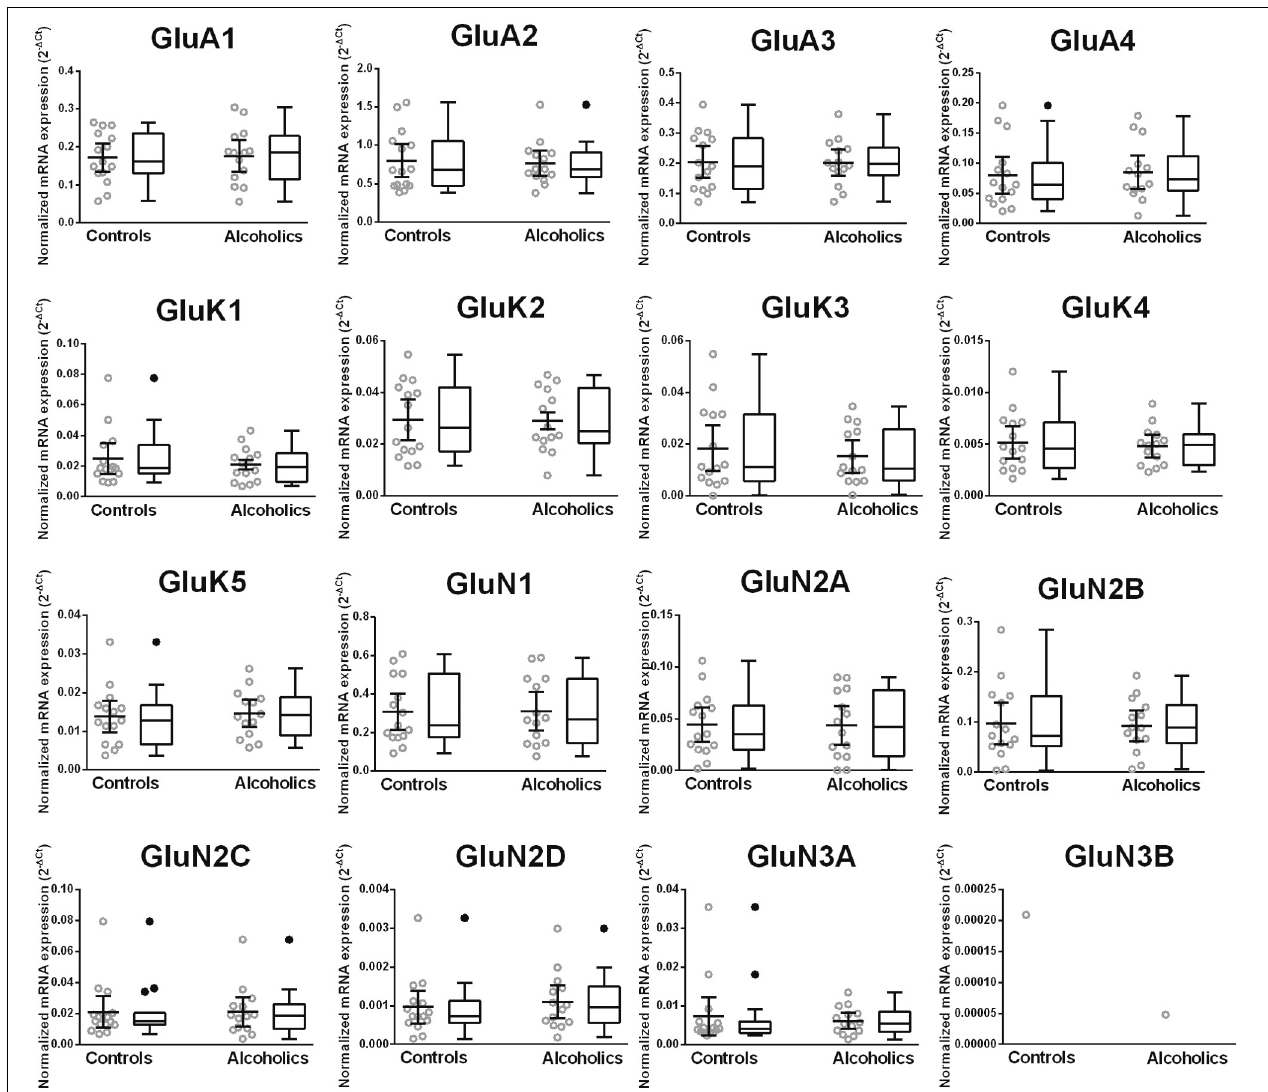
FIGURE 6 | Expression of ionotropic glutamate receptor subunits mRNA in the prefrontal cortex of controls ( n = 14) and alcoholics ( n = 11). Data from each group were presented as scatter dot plot ( ◦ ) with mean and 95% confidence interval and box and whiskers plot with median and whiskers plotted by Tukey method to determine outliers ( • -above or below the whiskers). Statistical analysis was performed after excluding outliers. One Way ANOVA with Bonferroni post-hoc test, GluA1, df = 23, p = 0 . 92;